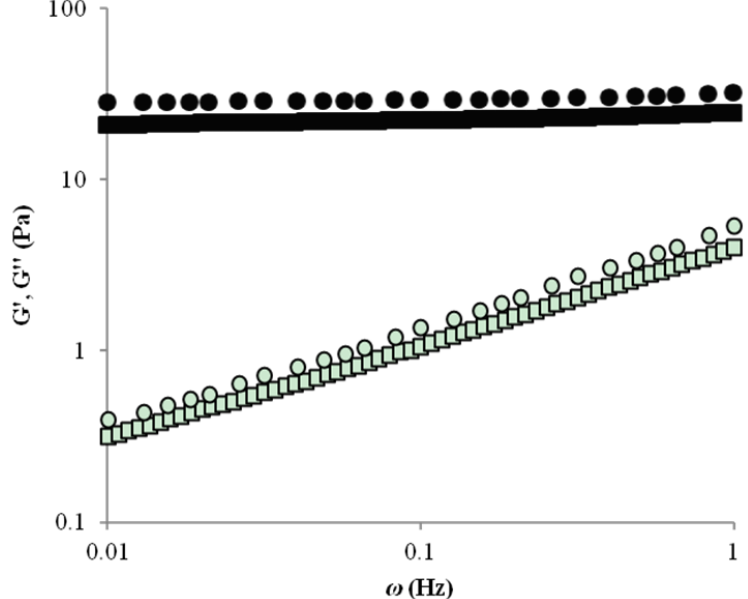
Figure 2. Mechanical spectra of 2% ( w/v ) WEAX gel, G' ( ● ), G'' ( ○ ) and 2% ( w/v ) WEAX gel containing B. longum , G' ( ■ ), G'' ( □ ). Measurements at 25 °C and 10%